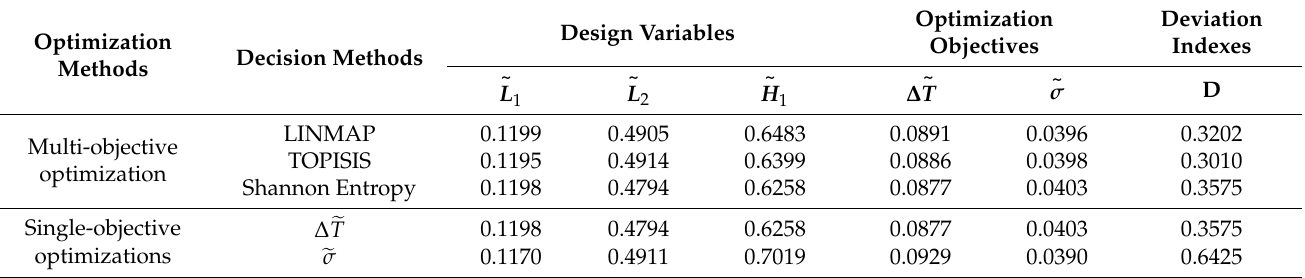
Table 3. Optimization results of the square HGB with different objectives under three-DOF optimi- zation.